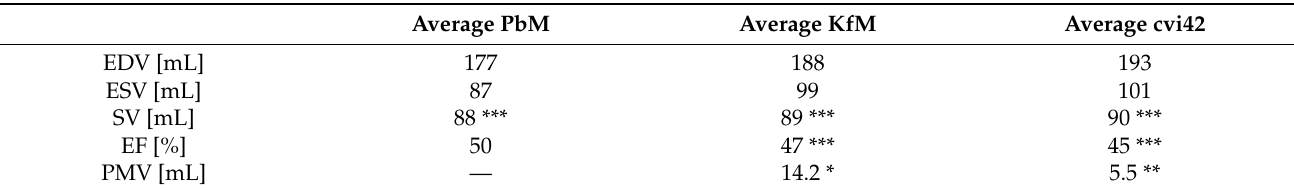
Table 1. Mean values: EDV = end-diastolic volume, ESV = end-systolic volume, SV = stroke